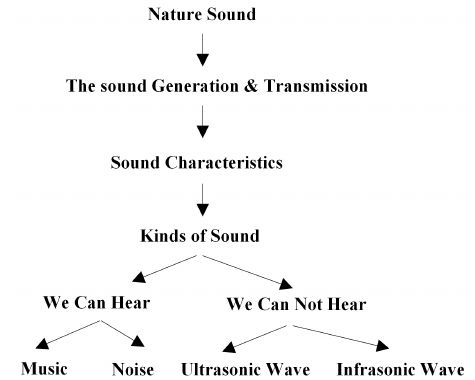
Fig. 6 “Physics Education” Ontology O 6 .